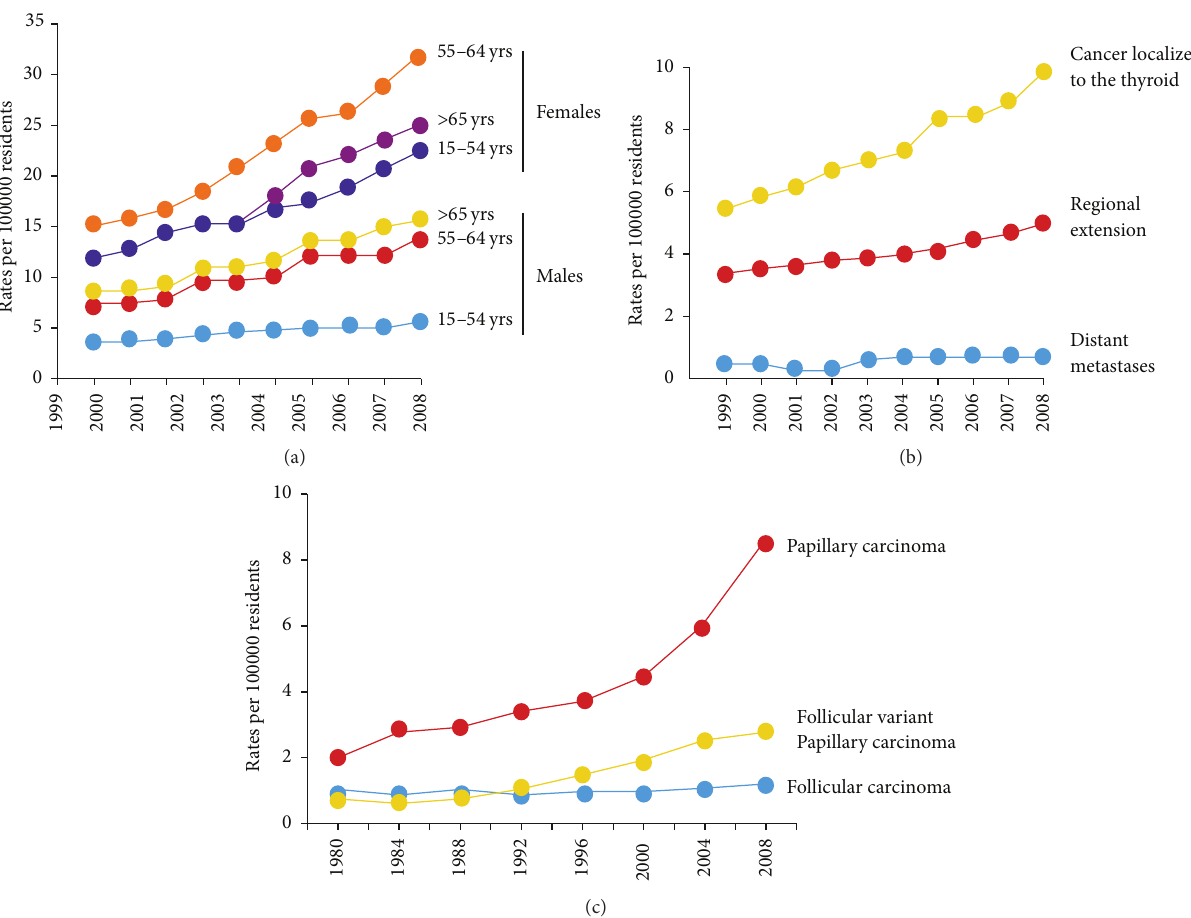
Figure 1: The trend in thyroid cancer incidence in the North American population from 1999 to 2008, subdivided by gender (a) and by disease stage at the time of diagnosis (b) (modified from Simard et al.) [11]. The trend in thyroid cancer incidence in the United States from 1980 to 2009 by histotype (c) (modified from Aschebrook-Kilfoy et al.)